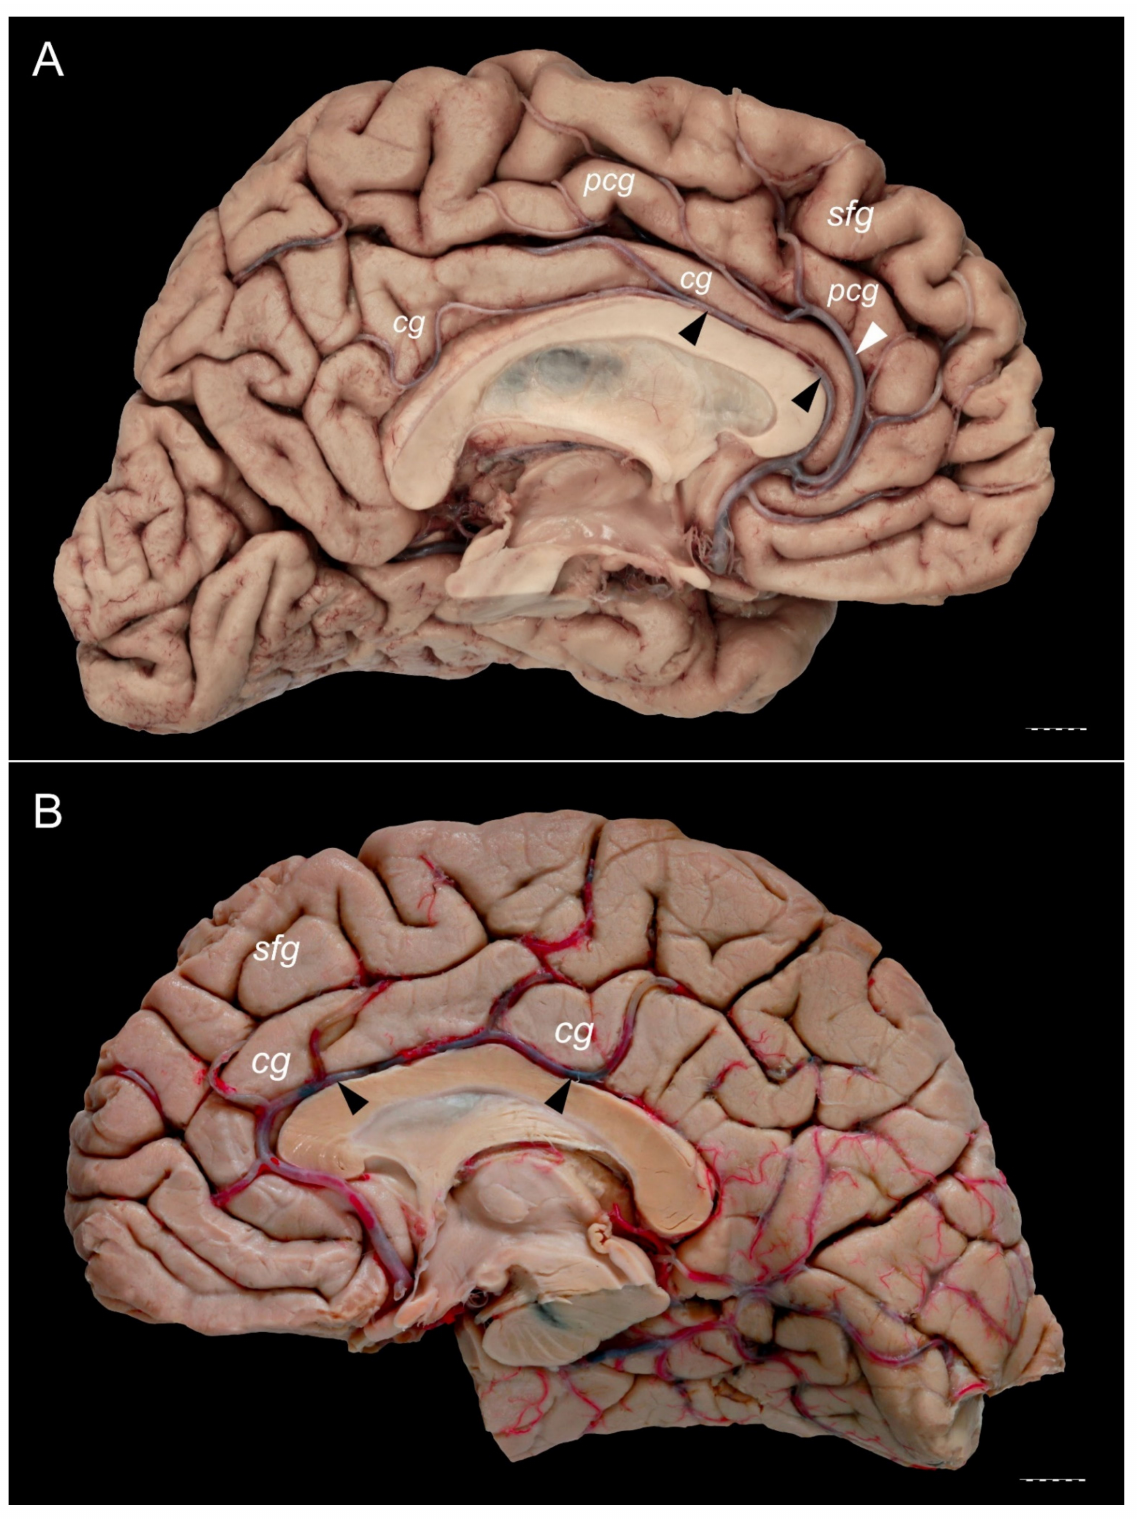
Figure 8. The relationships of the callosomarginal and pericallosal arteries. ( B ) Specimen showing a prominent type of the PCG. A pericallosal artery (marked by black arrowheads) and well developed callosomarginal artery (marked by white arrowhead) are present. Pericallosal artery is thinner than the callosomarginal artery on this specimen. ( A ) Specimen with absent PCG. Cingulate gyrus is well developed. Pericallosal artery (marked by black arrowheads) runs within the pericallosal sulcus, over the genu and superior surface of the body of the corpus callosum. cg—cingulate gyrus; pcg—paracingulate gyrus; sfg—superior frontal gyrus. Scale bar corresponds to 10